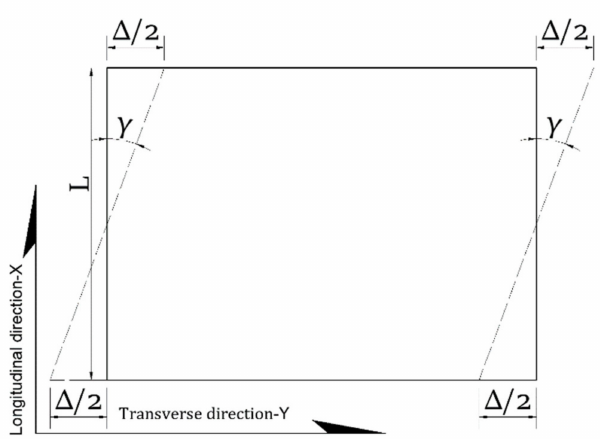
Figure 7. Shear deformation of the water